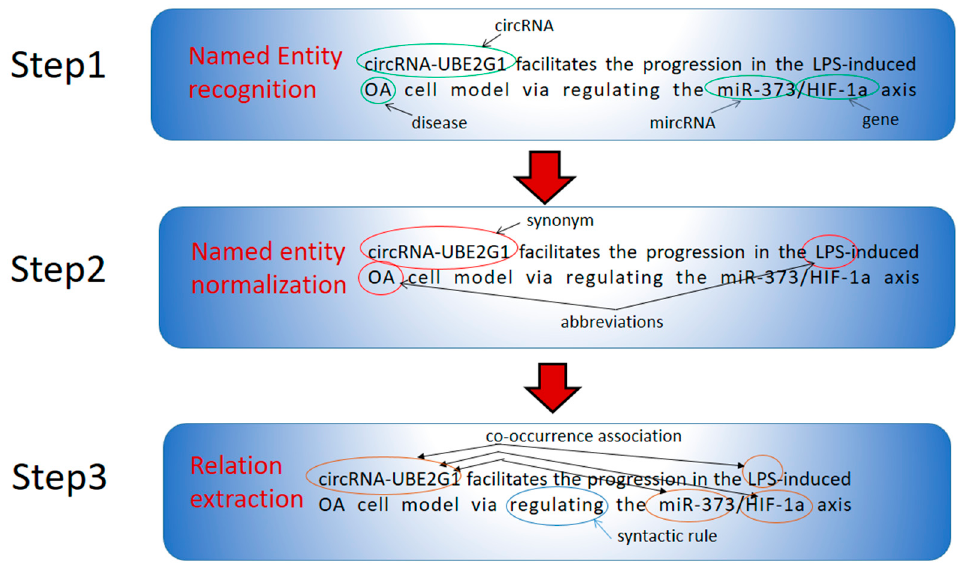
Figure 3. An illustration of NER, NEN and RE steps in text analysis. As an example, a real-world sentence from a circRNA research paper is used to visualize each step. In this first step, entity names, such as circRNA, gene and disease, are recognized; in step 2, word variations, such as synonyms and abbreviations, are removed by NEN methods; finally, entities’ relations are identified by co-occurrence-based, linguistic rule or machine learning methods.